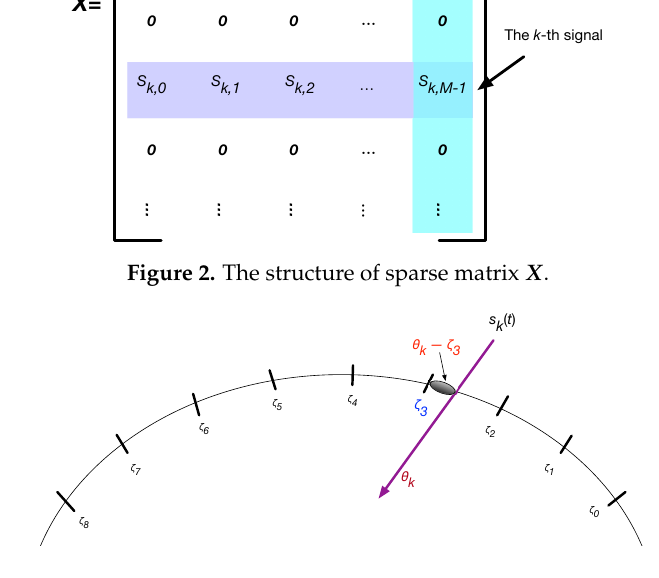
Figure 3. The off-grid approximation for